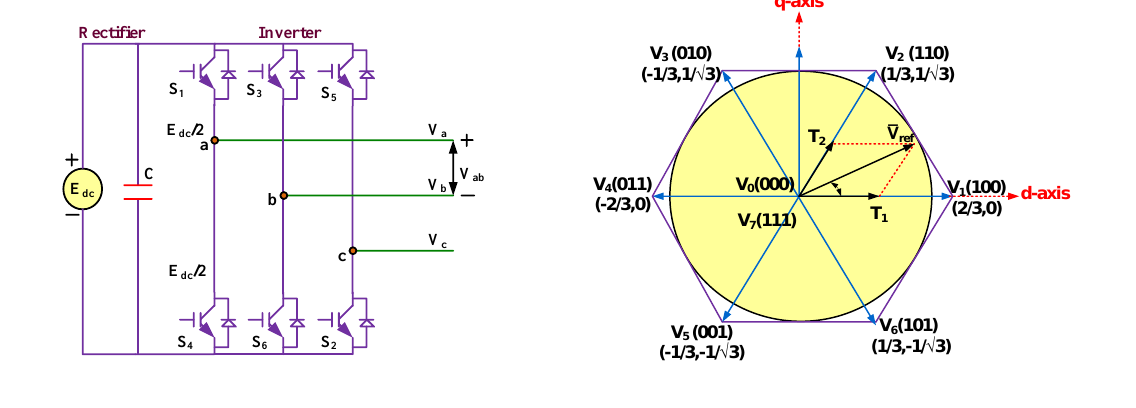
Figure 1. Schematic of SSTPI Figure 2. Space vector diagram for FSTPI